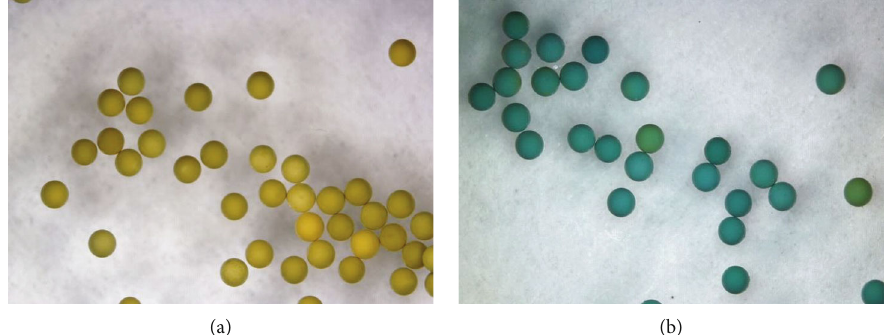
Figure 5: Microscope image (a) before adsorption and (b) after adsorption of copper (II) ion removal onto Dowex m4195.